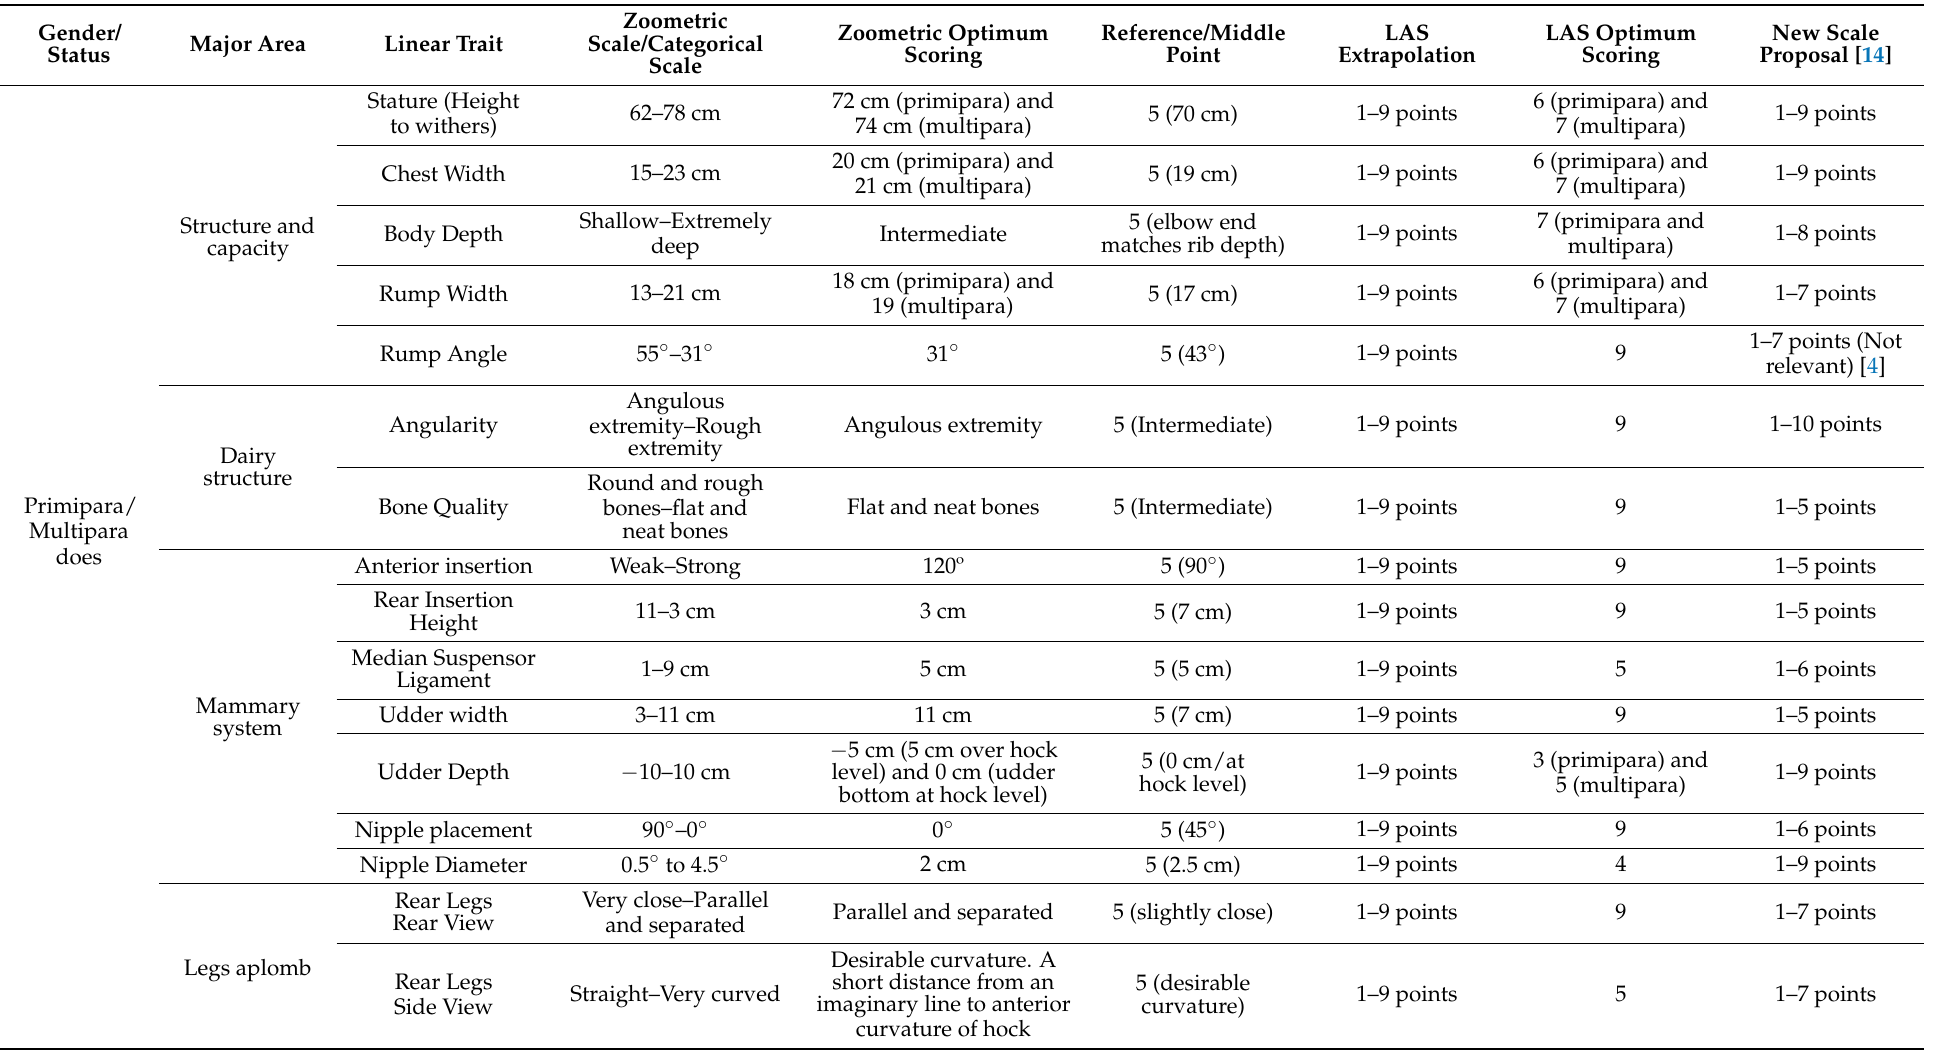
Table 1. Detailed description of the scales used and the translation process from zoometric traits to LAS scores in Murciano-Granadina goat and